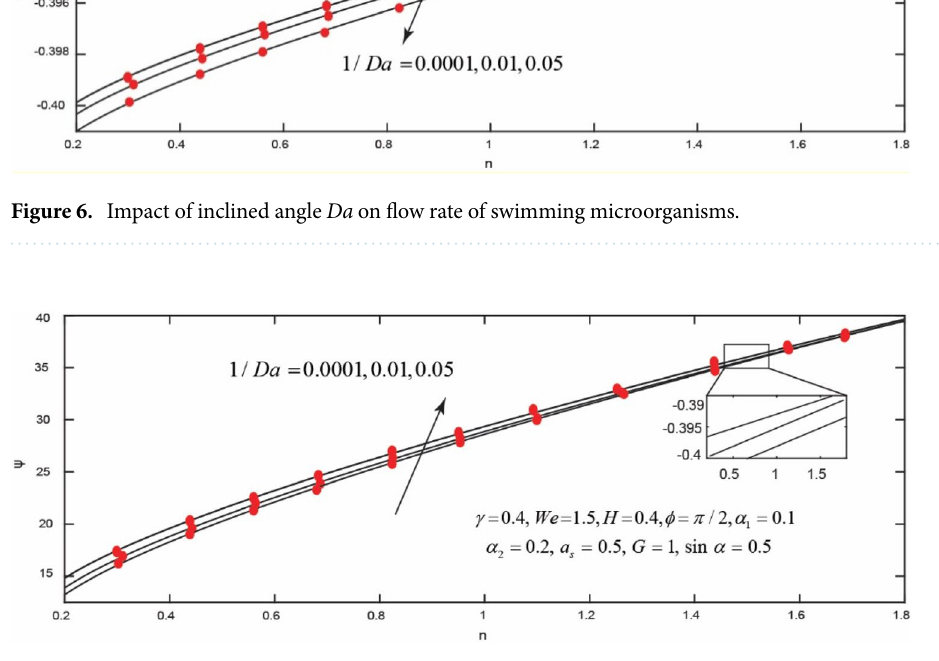
Figure 7. Impact of Da on power transferred by swimmers